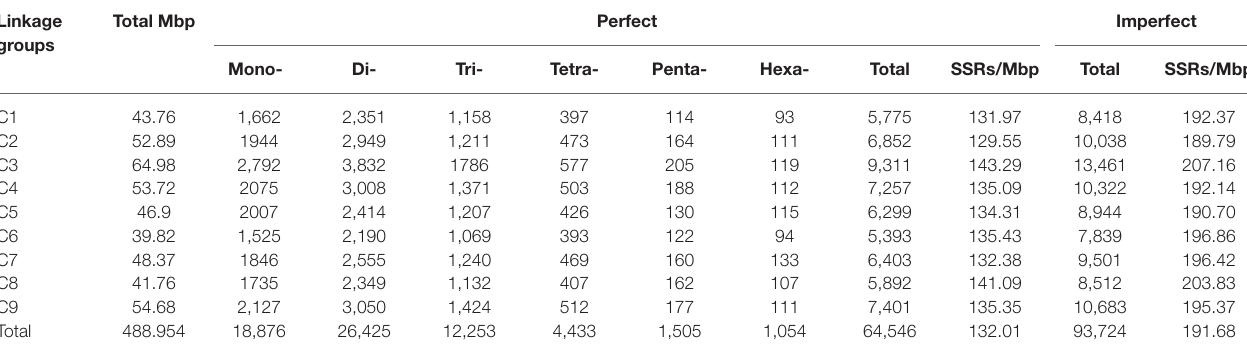
TABLE 3 | The chromosome-by-chromosome distribution of perfect, compound, and imperfect SSRs. Linkage